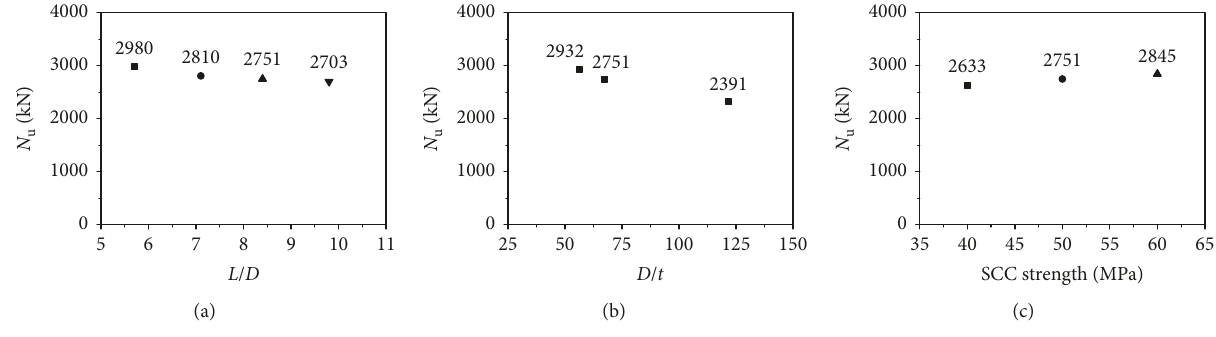
Figure 8: Load-bearing capacity of specimens. (a) L / D ratio. (b) D / t ratio. (c) SCC strength.